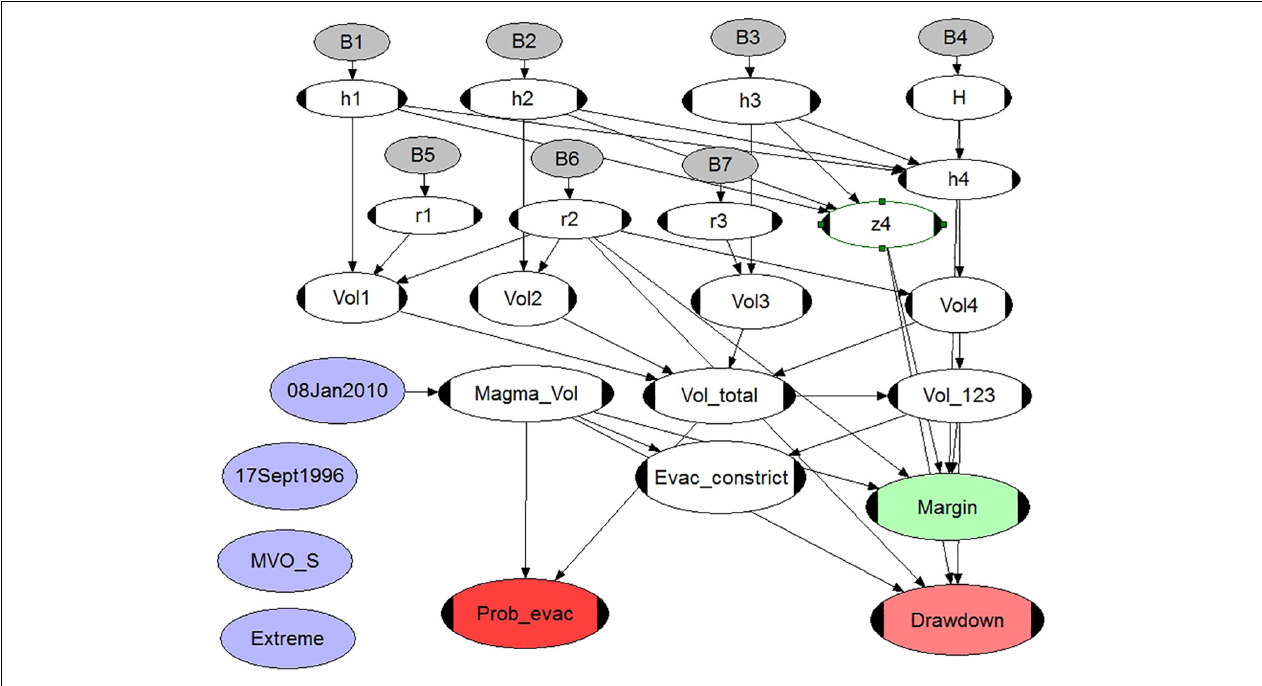
FIGURE 3 | UNINET BBN model for performing uncertainty analyses when calculating scenario-based conduit evacuation probabilities and conduit drawdowns. Four different explosion scenarios are shown as light purple nodes; these represent the “calibration” event, January 08, 2010 (actively linked in this analysis); the earlier September 17, 1996 explosion; MVO_S is the model-based minimum explosion volume needed to reach the observatory; and Extreme, a hypothetical scenario in which all the material erupted in the 1997 Vulcanians is modeled as erupted in one major event (see text and Supplementary Material)